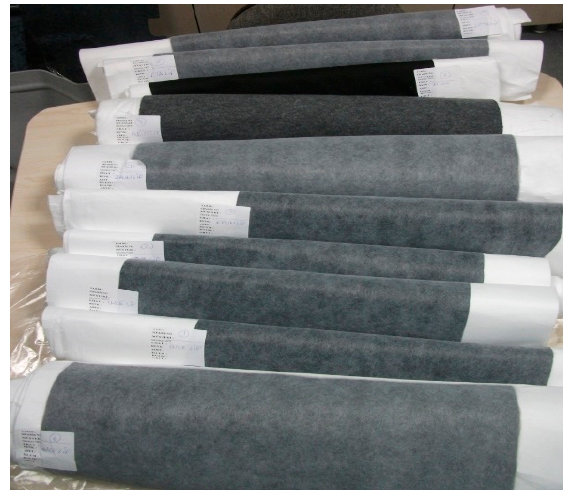
Figure 1. Photograph of 2 NP/MB hybrid fabric samples.